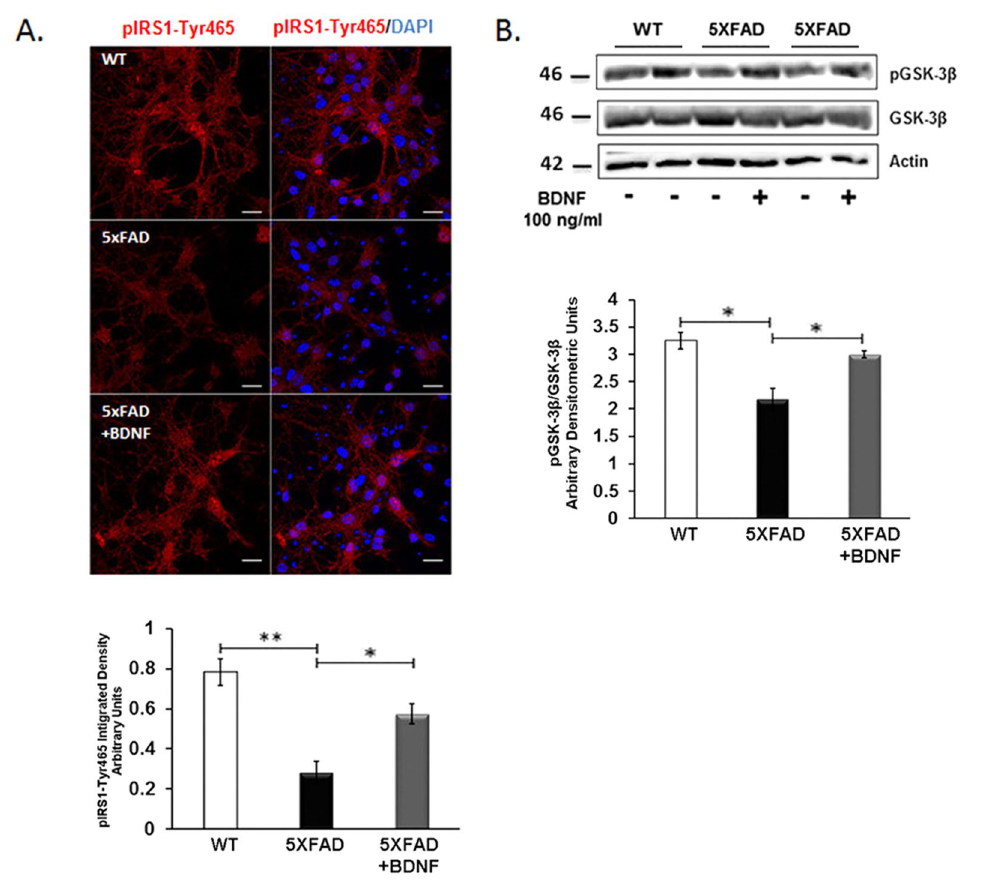
Figure 5. Primary hippocampal cultures of 5XFAD mice were treated with 100 ng/ml of recombinant BDNF for 30 min. ( A ) Cells labelled against pIRS1-Tyr465 antibody are depicted in red and cell nuclei labelled with DAPI are depicted in blue. Graph depicts quantification by the integrated density of total pIRS1-Tyr465. Magnification 63x, Scale bar: 20 μ m. ( B ) Equal amounts of total protein from treated cells were analyzed on 10% SDS-PAGE gels and immunoblotted with primary antibodies against pGSK-3 β and GSK-3 β . To ensure equal loading, membranes were re-probed against β -Actin. Graphs depict densitometric quantification of phosphorylated proteins normalized to their respective total protein levels. n = 3 ( A ) and n = 4 ( B ). All data are presented as mean ± SEM ( * p < 0.05, ** p <